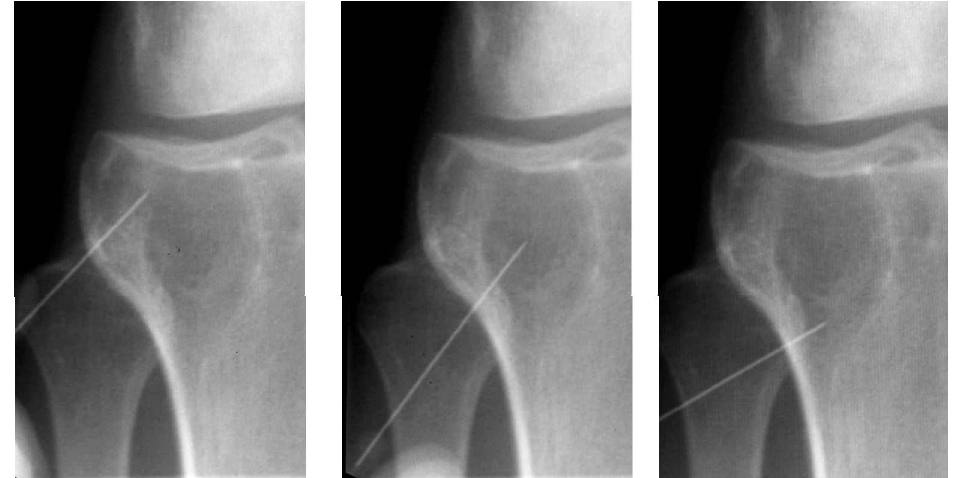
Fig. 1. GCT of proximal the tibia. Fluoroscopic guidance of FNAB into three different parts of the tumour. Cranially (a), centrally (b) and caudally (c).